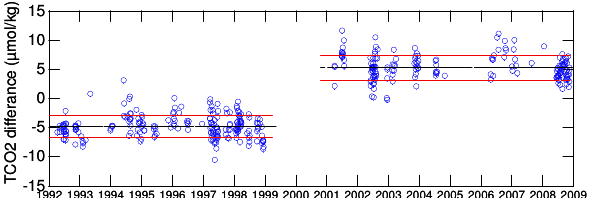
Figure 4. Results of MRI TCO 2 determinations in Dickson’s sea water reference materials (CRMs) in two periods 1992–1998 and 2001–2008. The average di ff erences (MRI-CRM) are shown as black slashed lines and their standard deviations are shown with red dotted